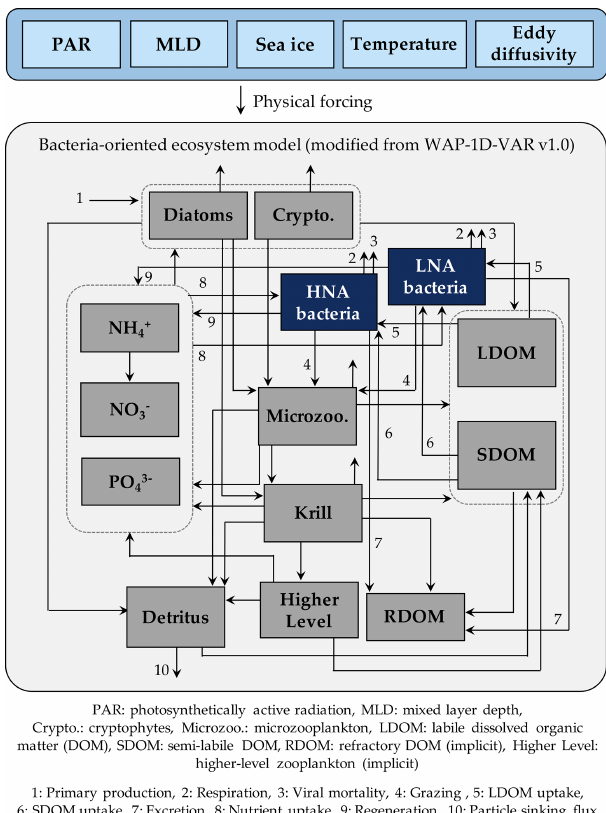
Figure 1. Model structure. The model is forced by five different physical forcings, denoted as a horizontal row across the top of the schematic. As the ecosystem component, heterotrophic bacteria are divided into two groups of differing physiological states, including high nucleic acid (HNA) and low nucleic acid (LNA) bacterial com- partments. The flows between the prognostic state variables with the name of the numbered flows in the legend only represent these two bacterial